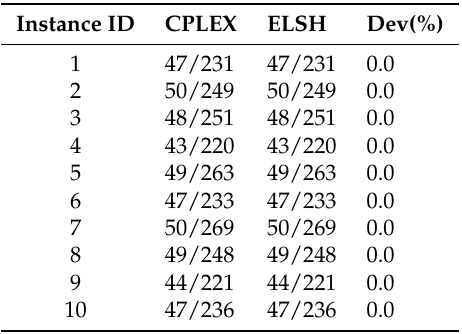
Table 2. Comparison with CPLEX on the set of 2-satellite, 50-node area distribution instances. Columns CPLEX and ELSH give the optimal solution found by CPLEX and the average result of ELSH, respectively. All the results of these two columns are associated with two numbers. The first number is the total number of targets observed and the second number is the final profit achieved. Columns Dev show the deviation between the best value found by ELSH algorithm and the optimal ). value found by CPLEX (100% ∗ CPLEX − ELSH CPLEX